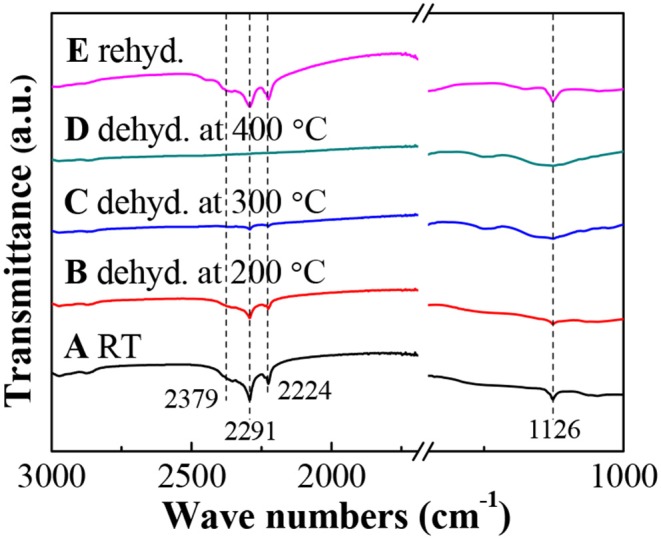
FTIR spectra of the LiBH4/np-Ni (1:5) system dehydrogenated at different temperatures and rehydrogenated.